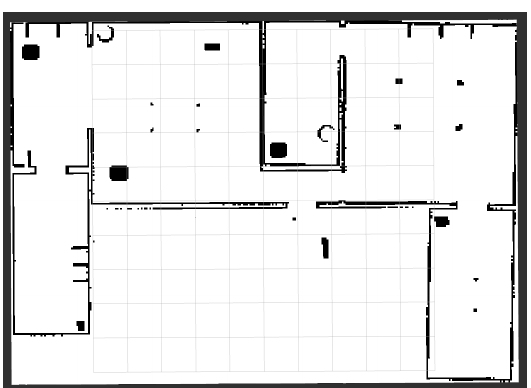
Figure 5. Grid map of the simulated environment.